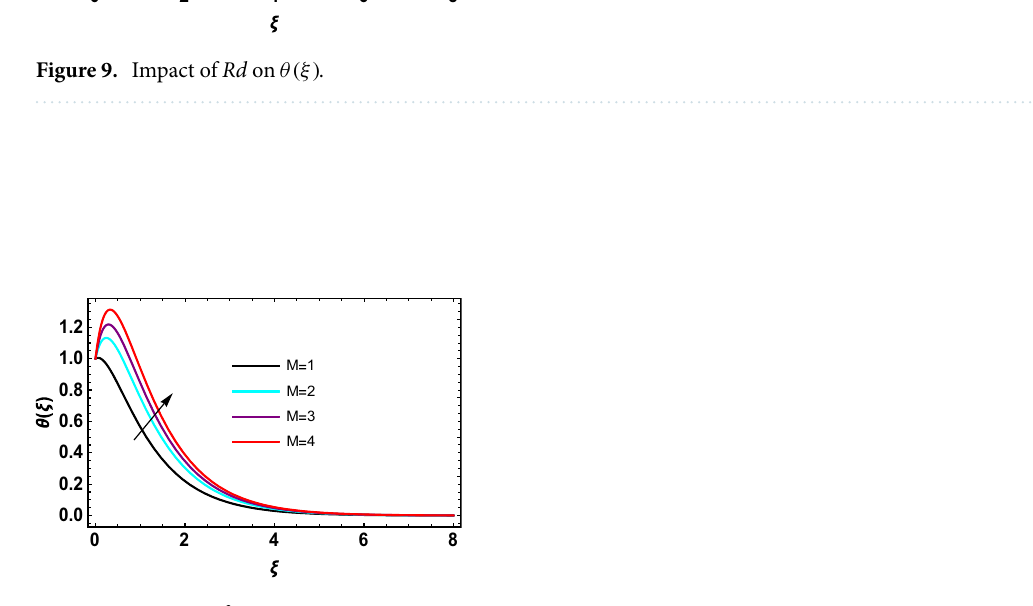
Figure 10. Impact of M on θ(ξ)